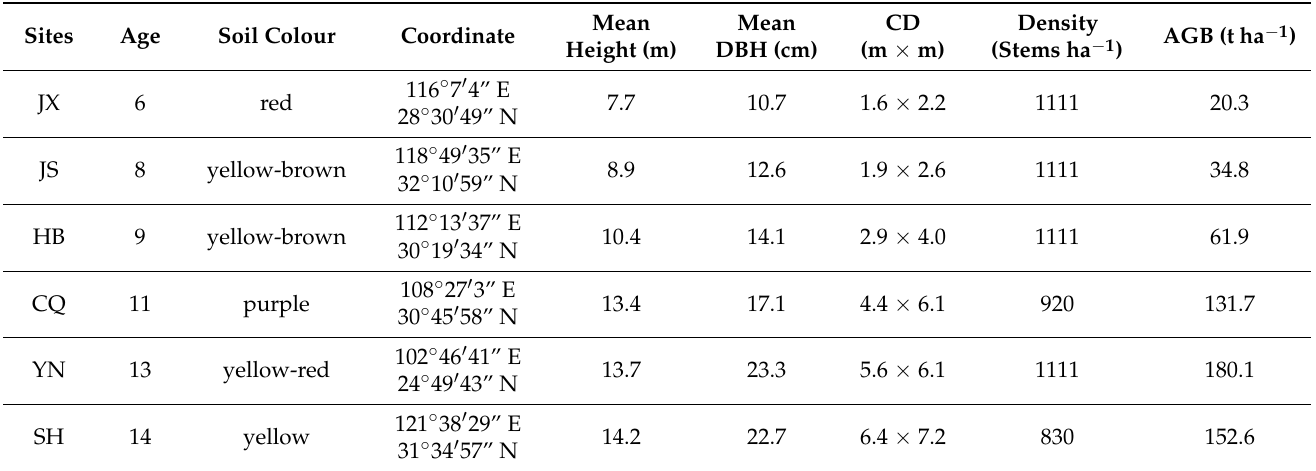
Table 1. General information of T . Zhongshanshan